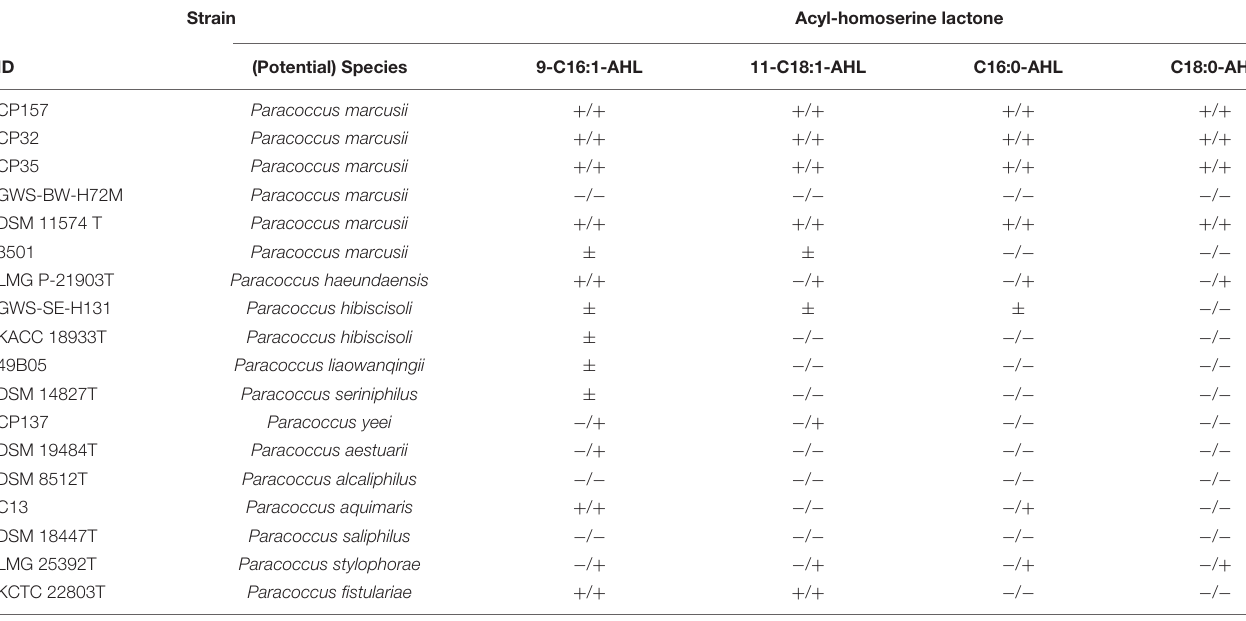
TABLE 2 | Acyl-homoserine lactones (AHLs) detected in Paracoccus crude extracts via GC/MS analysis.